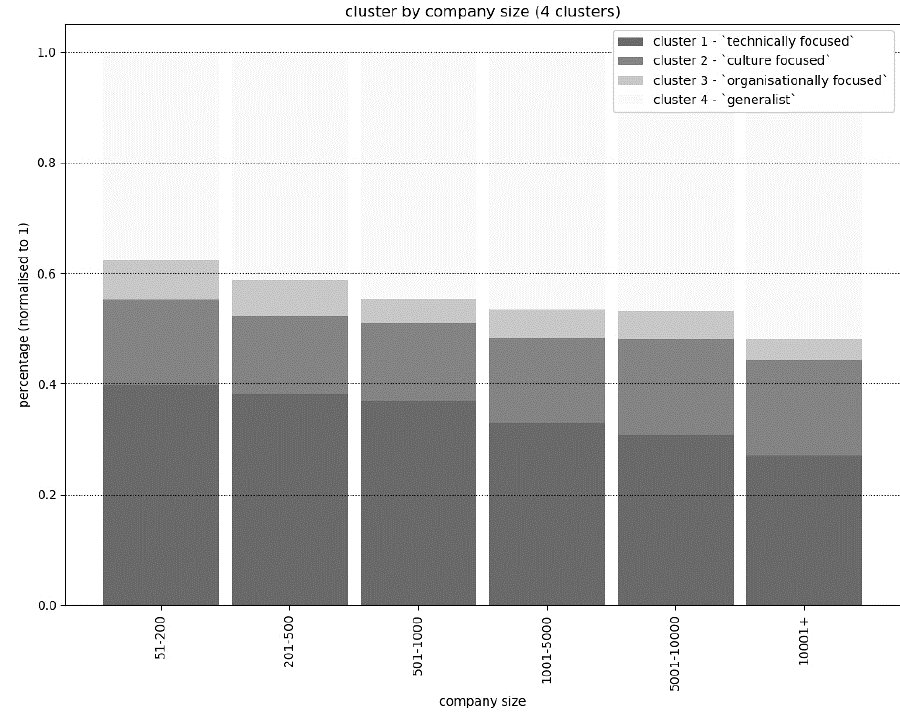
Figure 8. Distribution of clusters by company size